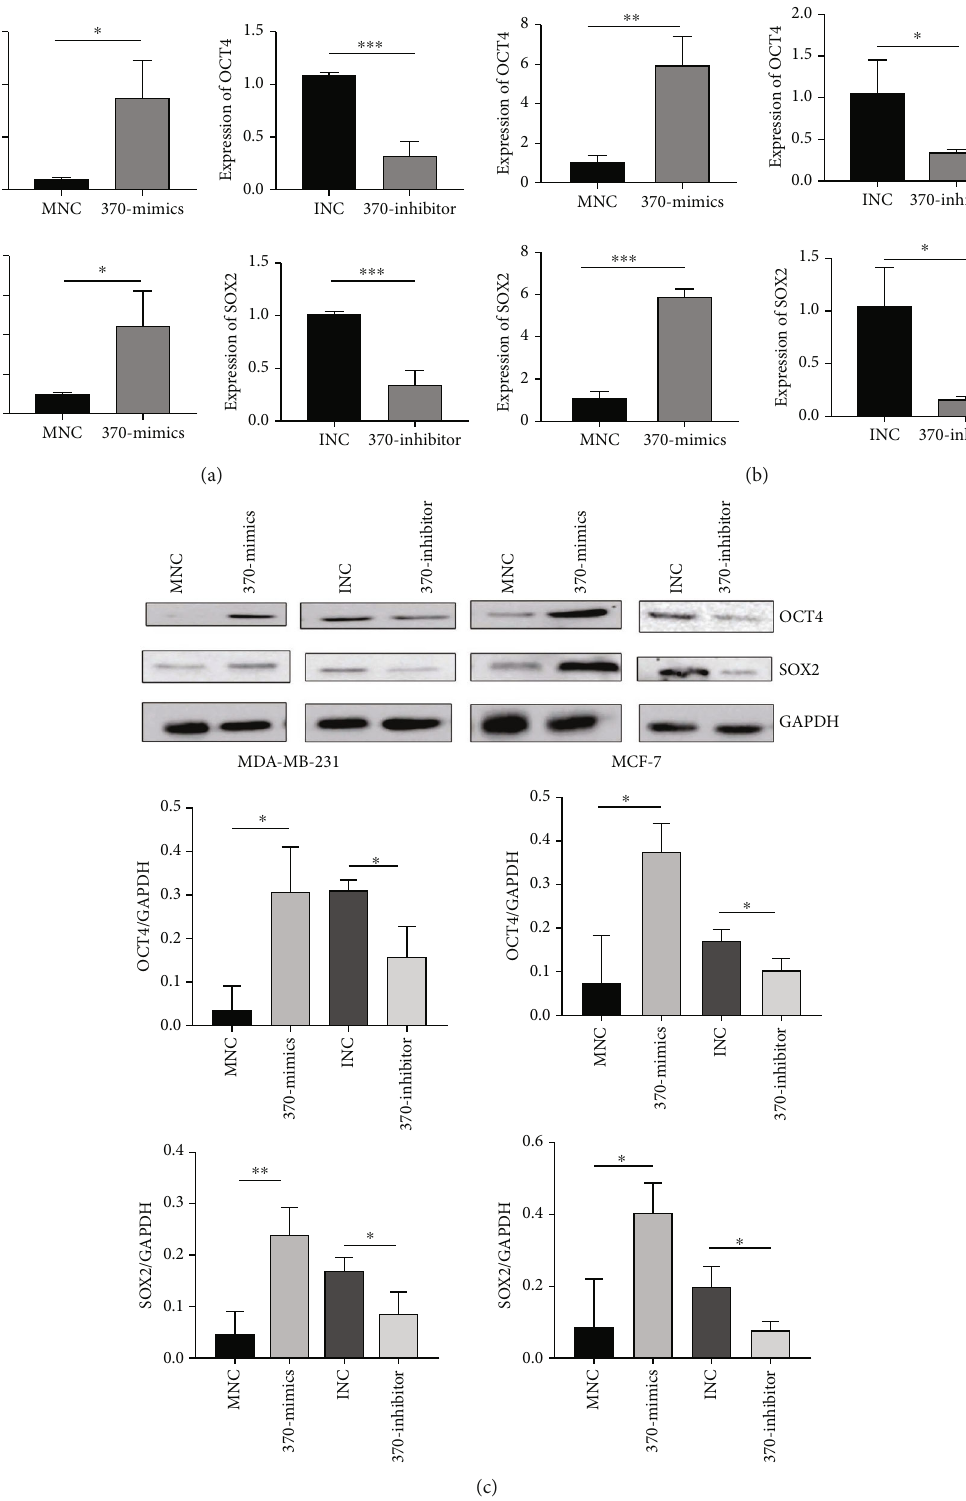
Figure 2: miR-370-3p promotes stemness of breast cancer cells in vitro . (a) The expression of OCT4 and SOX2 with MNC, 370-mimics, INC, and 370-inhibitor transfected breast cancer cells were examined by using quantitative RT-PCR. ∗∗∗ P < 0 : 001 , ∗∗ P < 0 : 01 , ∗ P < 0 : 05 . (b) The expression of stemness-related proteins in control and miR-370-3p-overexpressing cells or miR-370-3p knockdown cells was examined by using western blot. ∗∗ P < 0 : 01 , ∗ P < 0 : 05